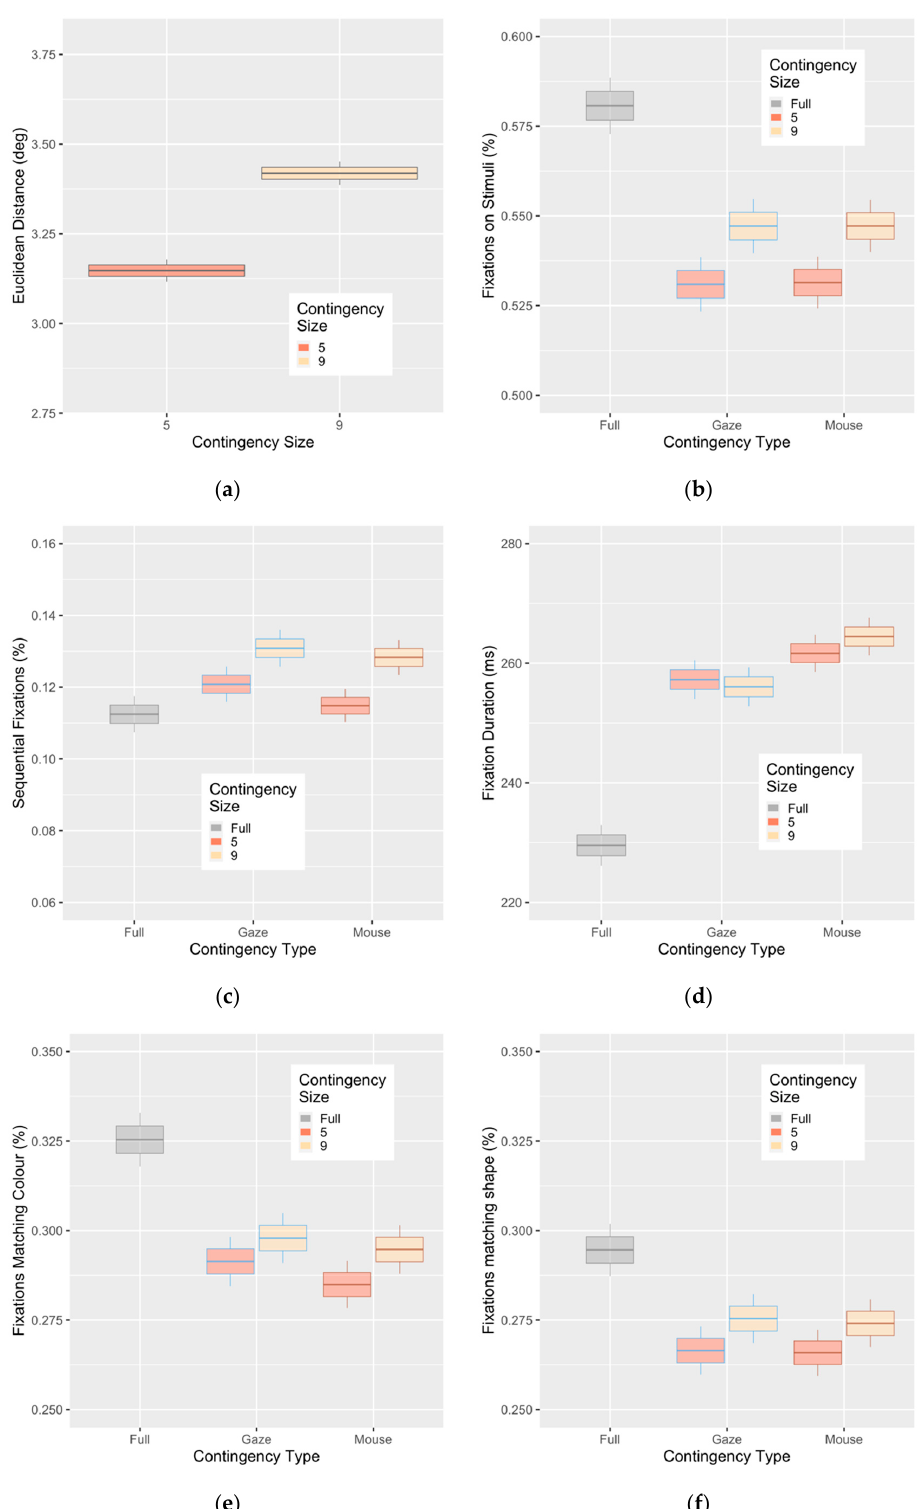
Figure 4. Metrics to determine if an effective covert strategy was used, including ( a ) the distance between mouse and gaze centers in the mouse-contingent condition; ( b ) the likelihood of fixations directly on stimuli (percentage from all fixations); ( c ) the likelihood of an adjacent stimulus being directly fixated on; ( d ) average fixation duration; ( e ) the likelihood of fixating a stimulus of the same color as the target; ( f ) the likelihood of fixating on the same shape as the target. Box plots represent category mean (center), standard error (box), and 95% CI